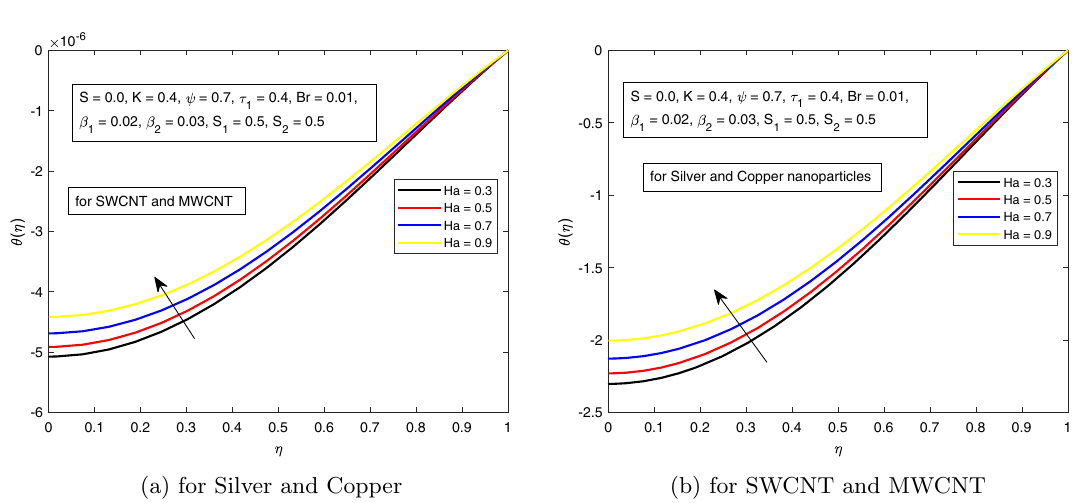
Figure 3. Influence of Ha on temperature distribution θ( r ) for the hybrid nanofluid combination of (a). Ag and Cu , (b) SWCNT and MWCNT